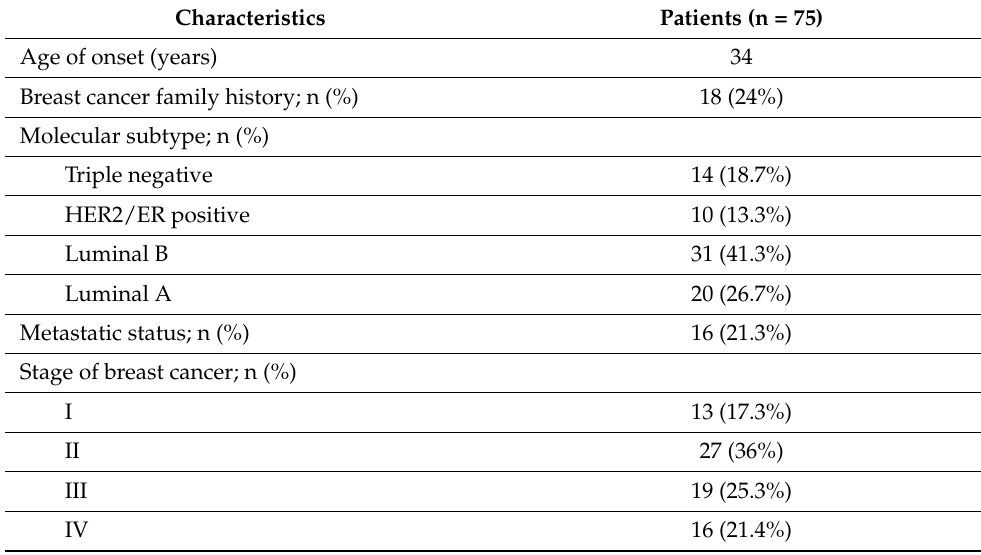
Table 1. Demographic characteristics of the breast cancer